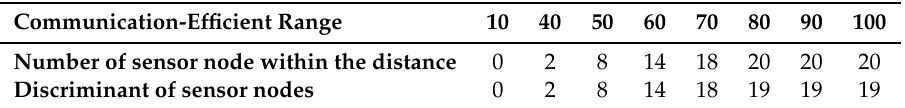
Table 1. Discriminant of sensor nodes in different communication-efficient range.